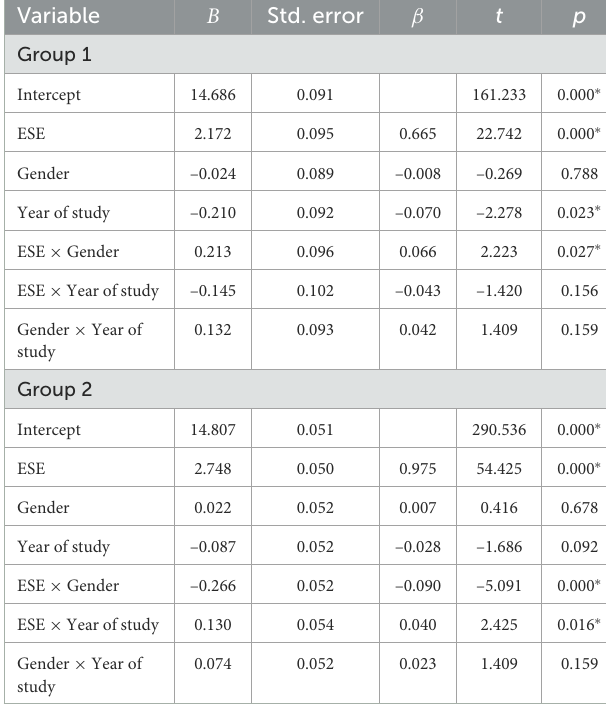
TABLE 5 Pearson correlation ( r ) of ESE factors with laboratory outcome score.